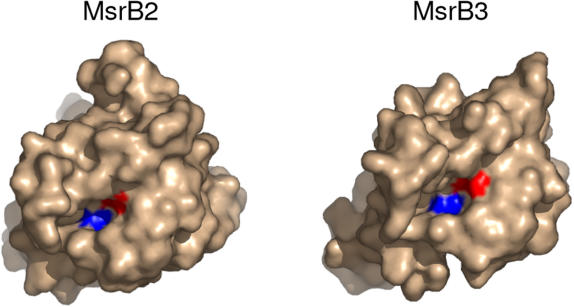
These surface models of mouse MsrB2 and human MsrB3 show the catalytic Cys95 residues in red and the Asn97 residues in blue